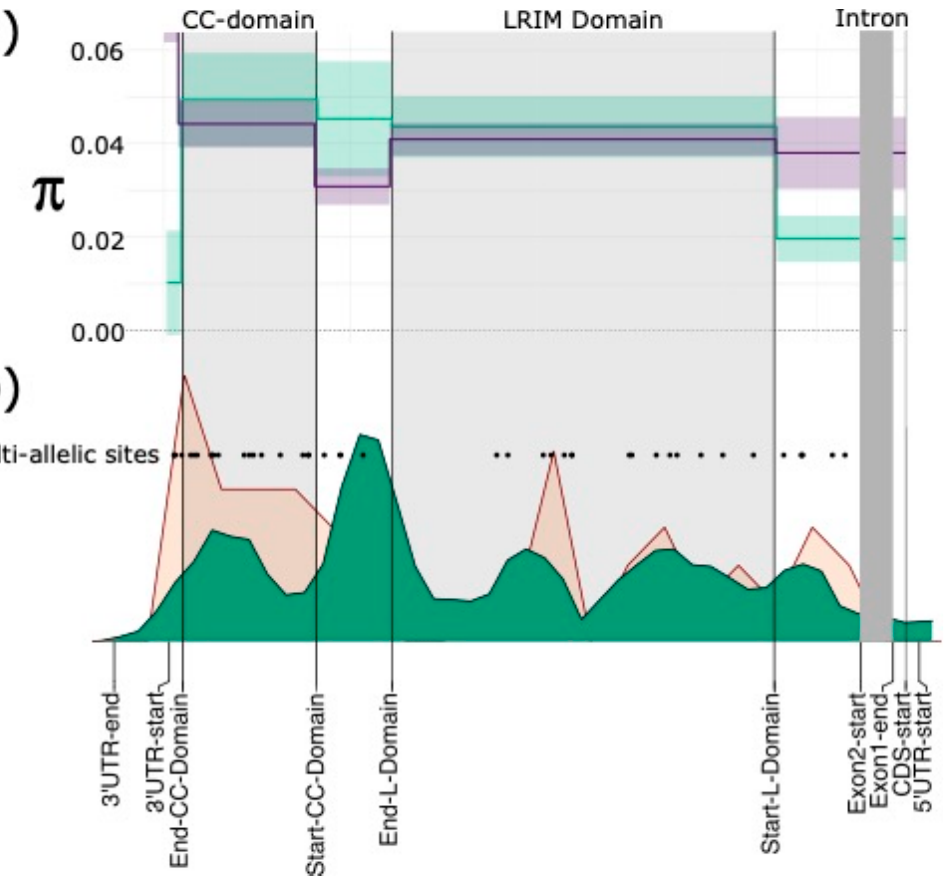
Figure 3. Diversity of APL1 domains and discordant read pair mappings. ( a ) Nucleotide diversity ( π ) for non-synonymous sites in purple and synonymous sites in green; line is mean across twelve PoolSeq populations and shaded area is standard deviation; ( b ) Discordant read mapping density across the APL1 gene-body is given in green in lower figure, density of multi-allelic positions is shown in salmon pink and positions of such sites are plotted as black dots labelled “multi-allelic sites”. CC-Domain is the region encoding two coiled-coil motifs and LRIM domain, both are shaded in light grey. The single intron is shaded in dark grey. Domains, exon and untranslated region positions are given on the X